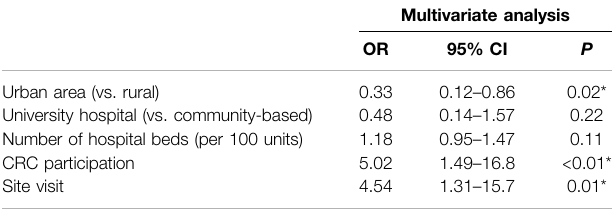
TABLE 2 | Factors associated patient enrollment (n (cid:1)